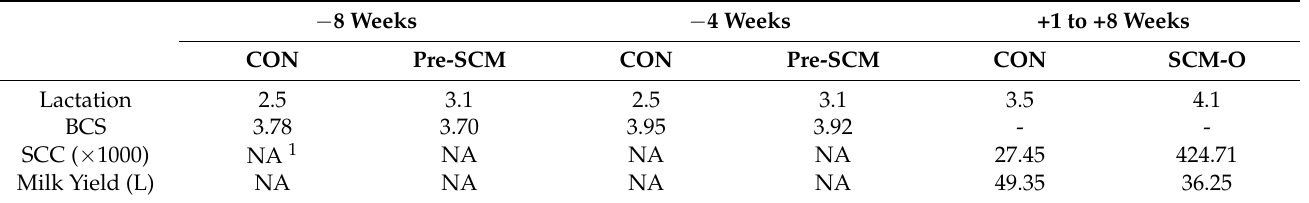
Table 3. General cow performance data (average), such as body condition score (BCS) and lactation number at − 8 weeks and − 4 weeks prior to the expected date of calving as well as somatic cell count (SCC) and milk yield measured for 8 weeks after calving.